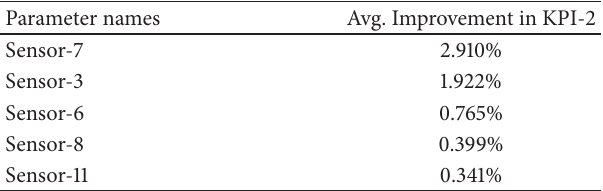
Table 9: Ranking of sensors based on average volatility reduction (KPI-2).